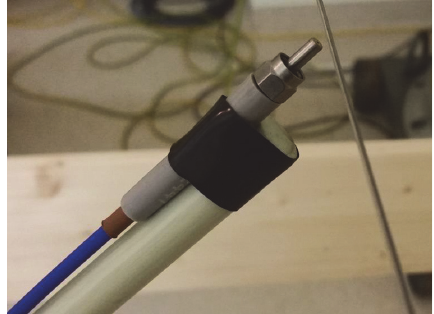
Figure 1: General view of the test station in laboratory: A, spectrophotometer, B, head of the fi bre optic cable which transmits optical signal to the spectrophotometer, and C, power transmission lines.